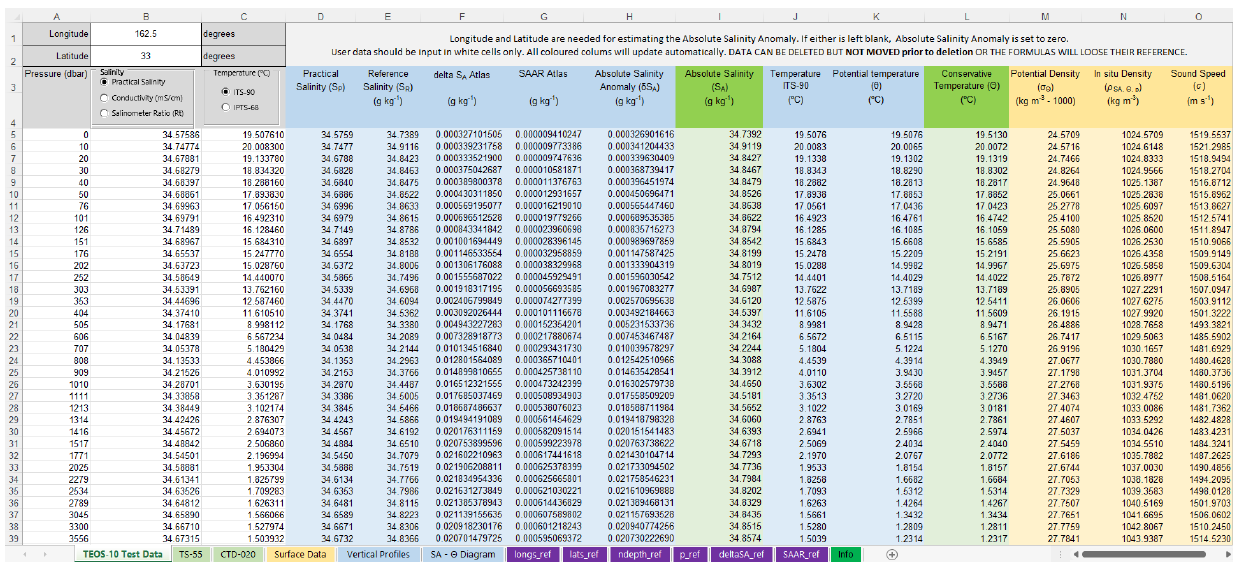
Figure 1. TEOS-10 Excel workbook (v.2.1) light green data tab. Seawater properties in coloured columns are computed on the fly from user data pasted into white cells.